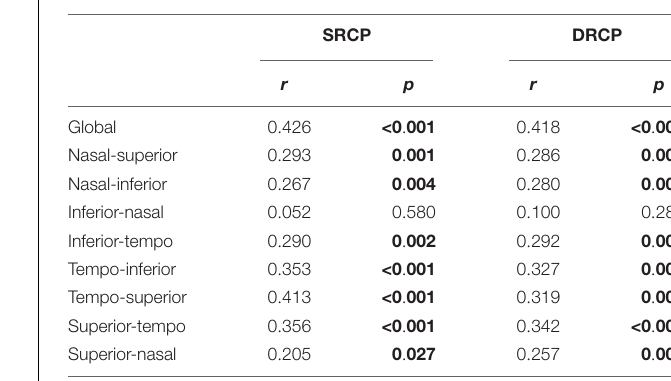
TABLE 7 | The correlation between the macular retinal microvascular density and radial peripapillary capillary (RPC) density.